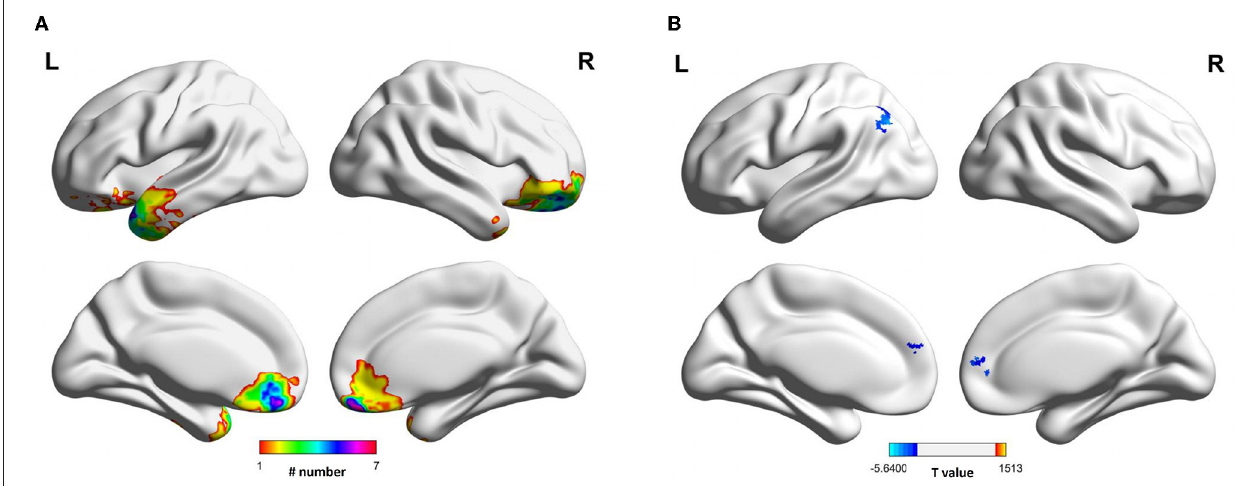
FIGURE 1 | Lesion map and functional connectivity of left substantia nigra following traumatic brain injury. (A) The focal lesions visible on MRI scannings were mainly overlapped in the anterior frontal and temporal lobes. (B) The functional connectivity between left substantia nigra and bilateral superior medial frontal gyrus, and left angular gyrus was decreased in TBI group.